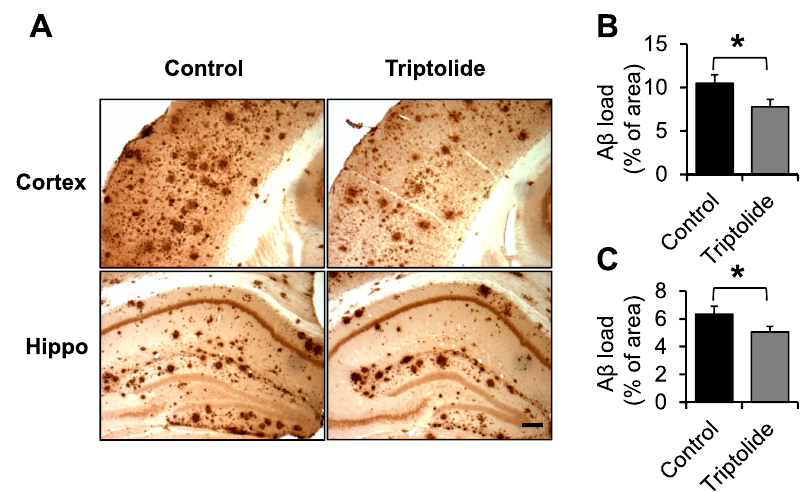
Figure 4. Triptolide treatment significantly decreases cerebral A b plaque load in APP/PS1 mice. A , Representative brain sections of cortical and hippocampal areas from different groups immunostained with anti-A b antibody (6E10). B,C , Quantification of the percent amyloid load in the cortical ( B ) and hippocampal ( C ) areas, showing a significant reduction in the triptolide-treated group when compared to the control group. N=7 mice/group; Age =8.6 months; *, P , 0.05. Scale bars =100 m m.